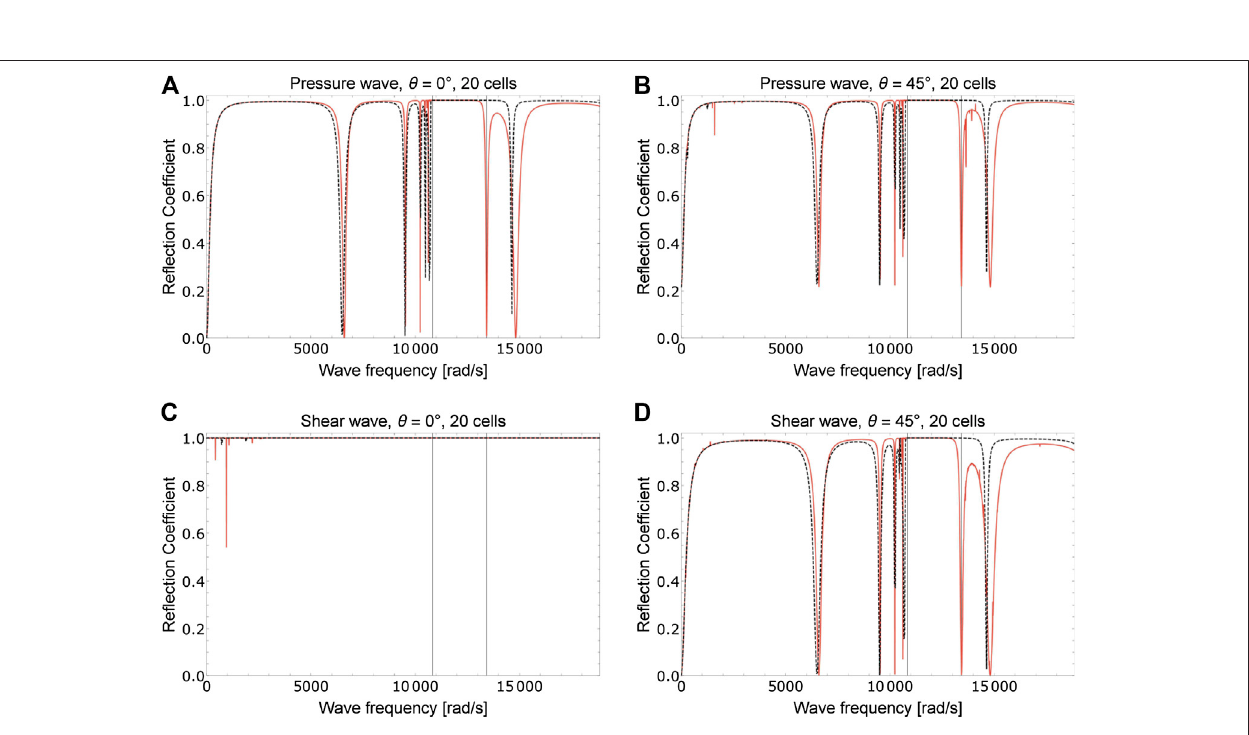
Frontiers in Materials |